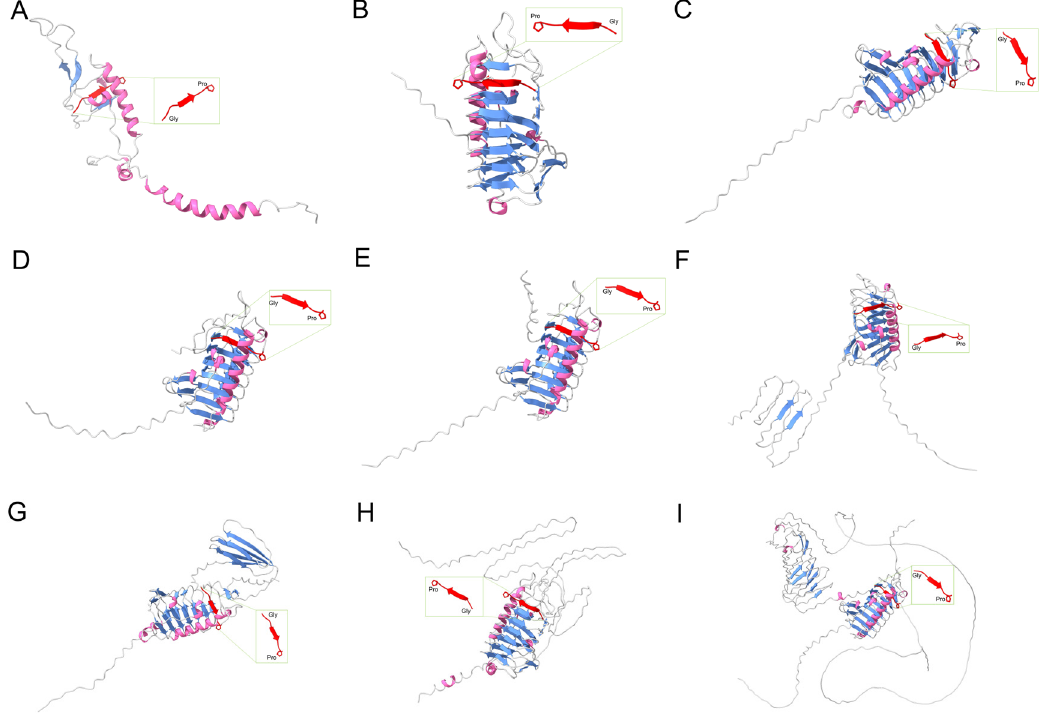
Figure 4. Modeled structure of the AFPs in G. antarctica strain PI12. Accession numbers: ( A ) ACX31168.1, ( B ) AEG19527.1, ( C ) AEG93831.1, ( D ) AEG93832.1, ( E ) AEG93833.1, ( F ) AEG93834.1, ( G ) AEG93835.1, ( H ) AEG93836.1, and ( I ) AEG93837.1.